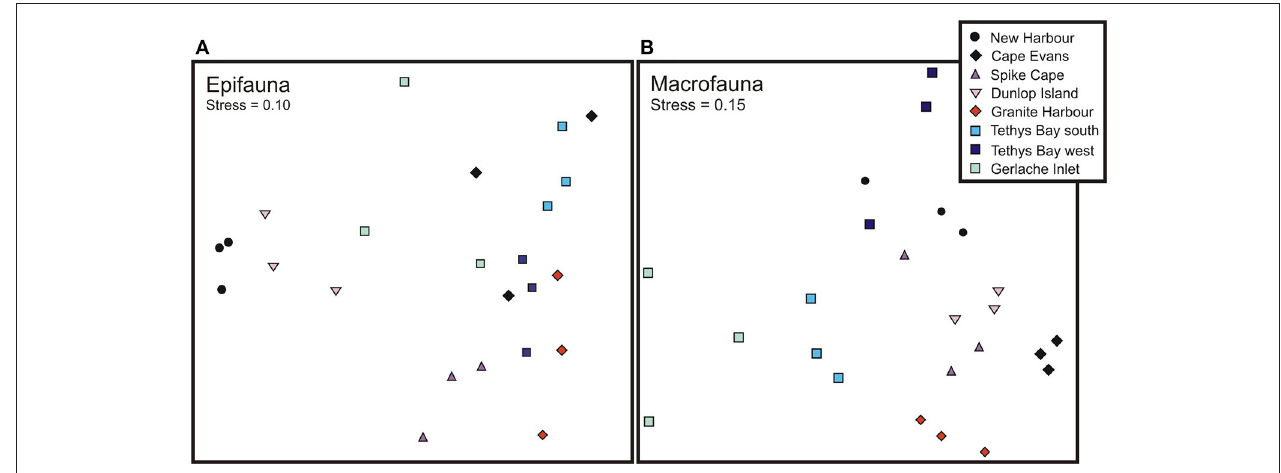
FIGURE 2 | Multidimensional Scaling ordination plot of (A) epifaunal and (B) macrofaunal community composition.